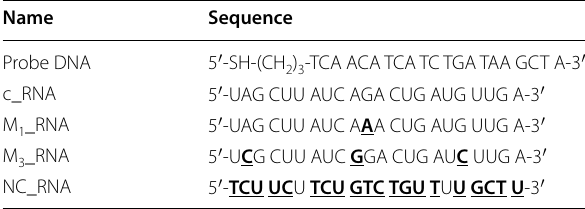
Table 1 DNA and RNA sequences used in the